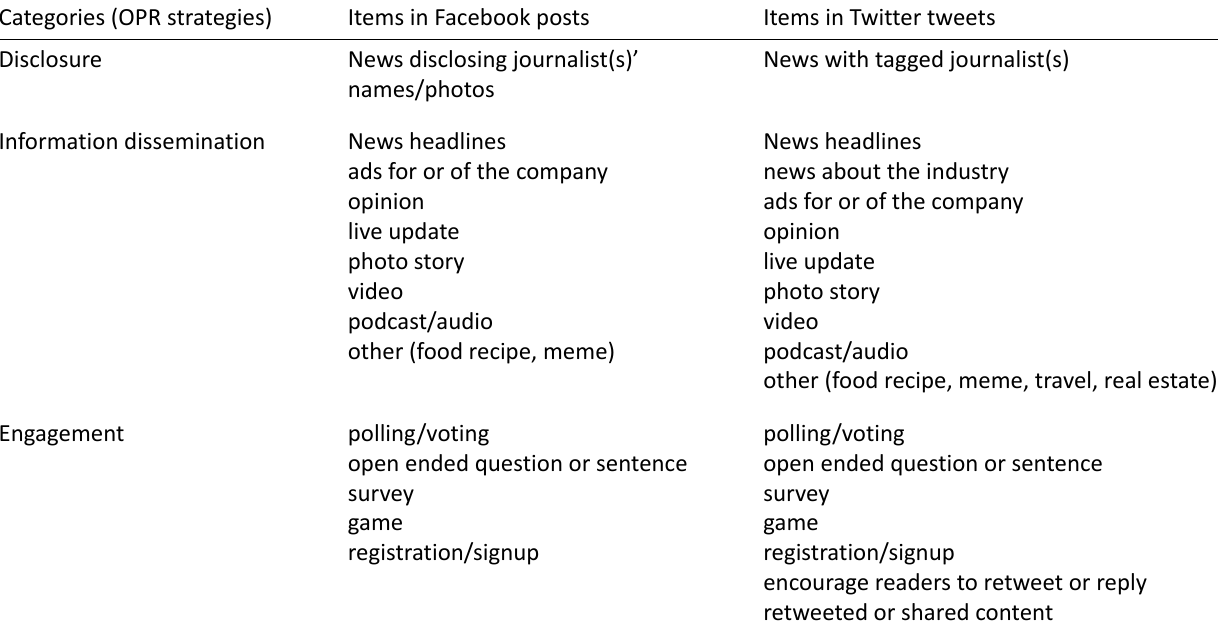
Table 1. Summary of items used to identify OPR strategies used by newspapers in Facebook and